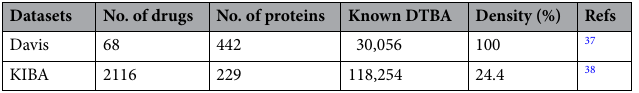
Table 1. Statistics for the drug-target binding affinity benchmark